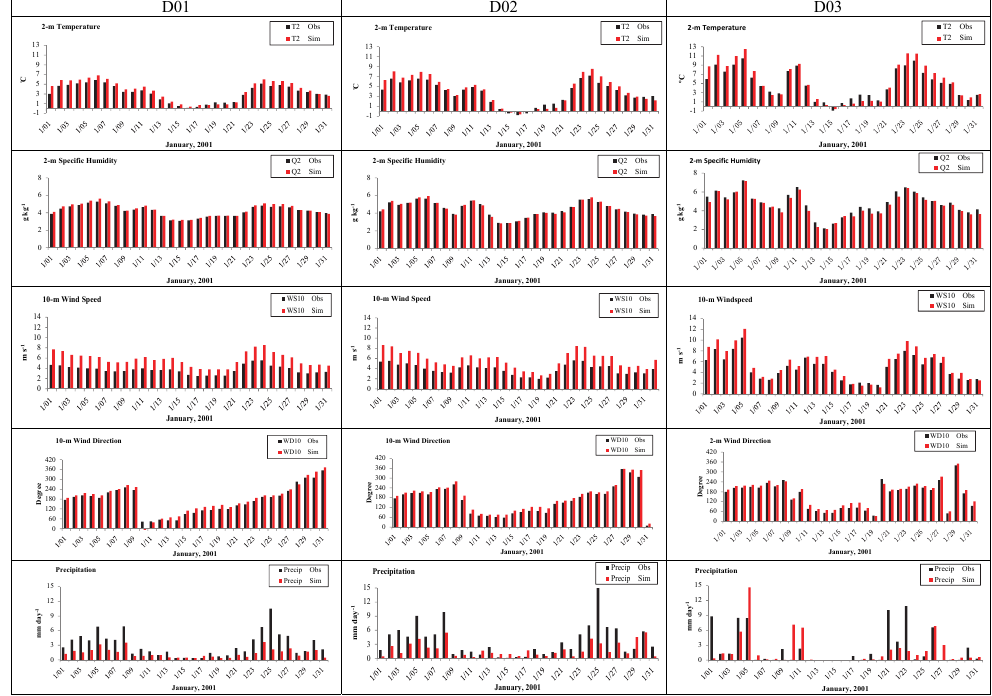
Figure 6. Simulated and observed daily mean T2, QV2, WS10, WD10, and precipitation by WRF in January 2001 over D01 (left column), D02 (middle column), and D03 (right column).